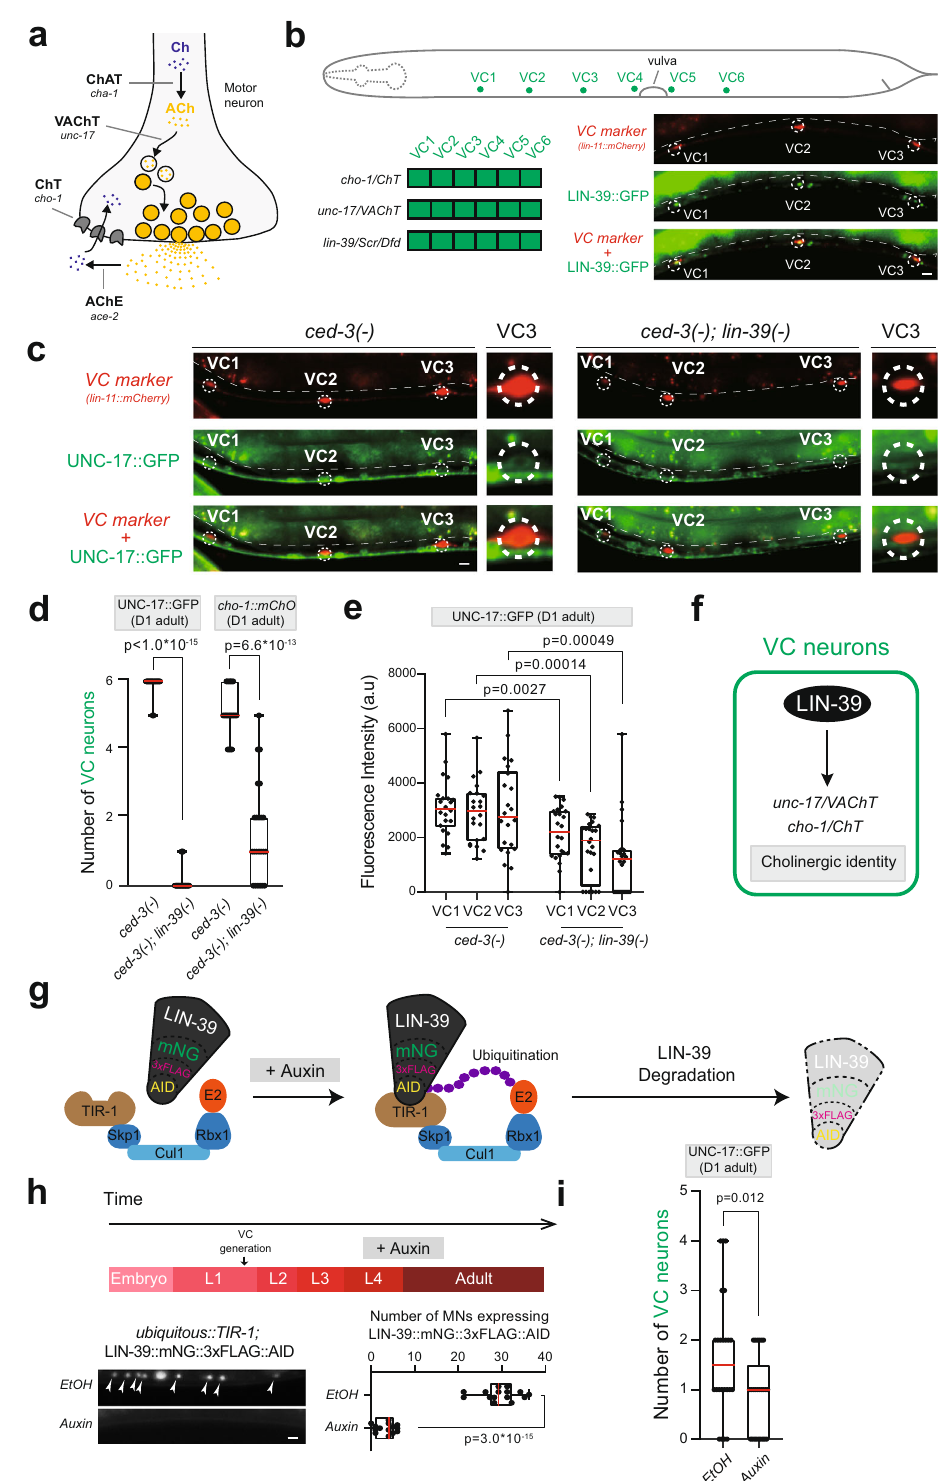
different classes (types) of MNs within its ventral nerve cord that are cholinergic 13 . Five classes (DA, DB, VA, VB, AS) control locomotion and are sex-shared (found in C. elegans males and hermaphrodites), whereas one class (VC) controls egg-laying and is found only in her- maphrodites. Each MN class contains several members (DA=9 neu- rons, DB=7, VA= 12, VB=11, AS =11, VC =6) that intermingle along the nerve cord. The cholinergic identity of these MNs is de fi ned by the